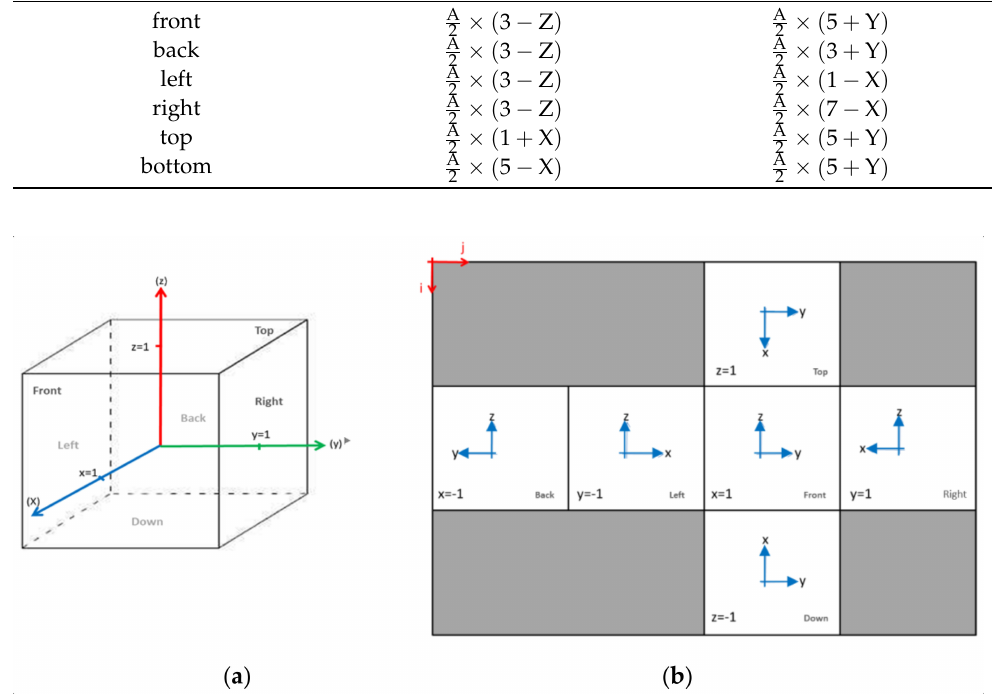
Figure 9. ( a ) Cube coordinate system before development; ( b ) cubemap indexing